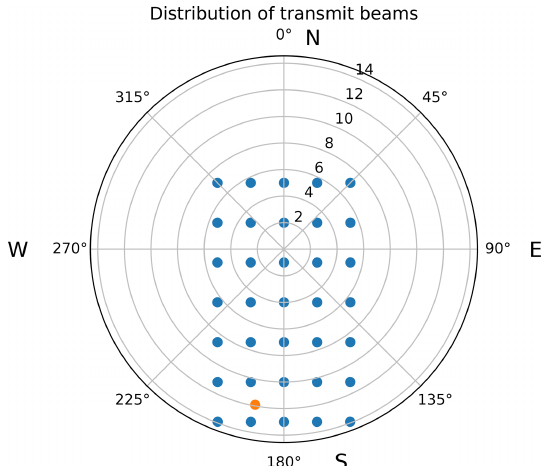
Figure 5. Azimuth–elevation distribution of transmit beams. The orange dot shows the direction of the magnetic field in 2022 as cal- culated with the IGRF